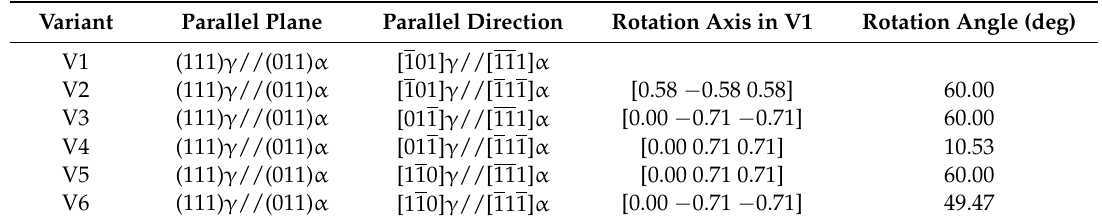
Table 3. The 24 variants for the K ‐ S orientation relationship (V1–V24).